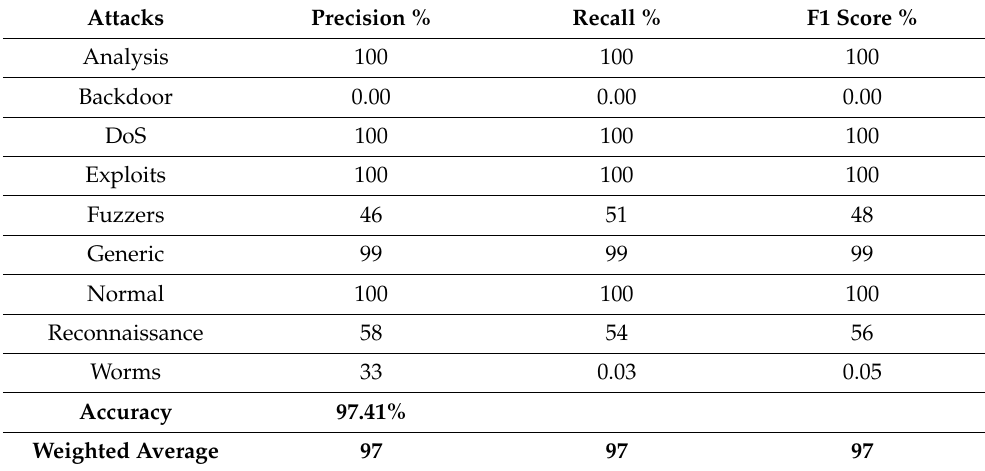
Table 6. Results of the KNN on multi-classification.